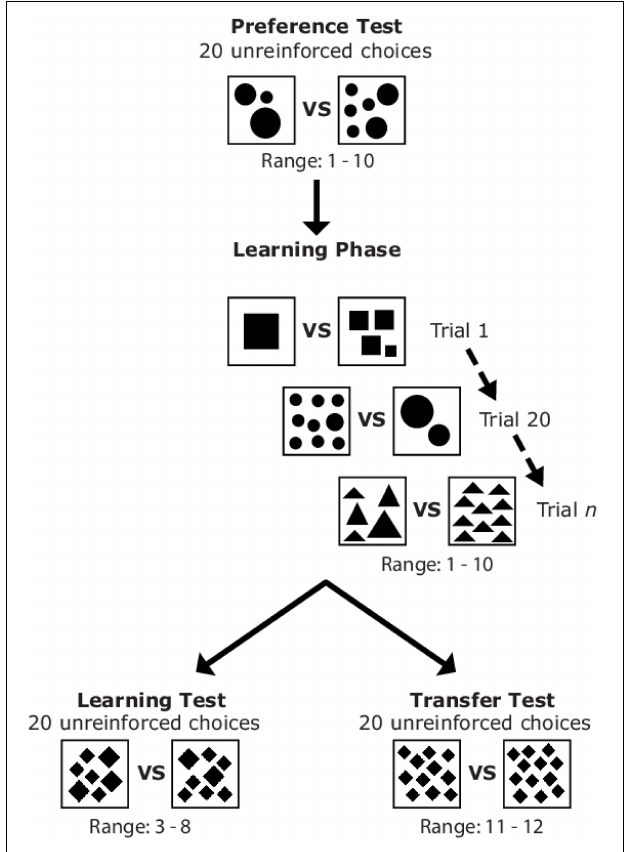
FIGURE 1 | Sequence of the different phases of Experiment 1 and examples of stimuli which could be presented to a bee during the preference test, learning phase, learning test, and transfer